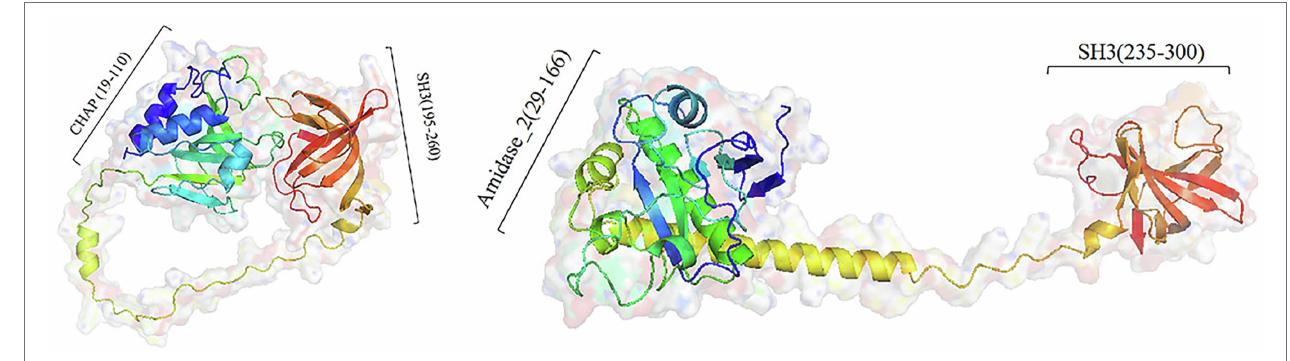
FIGURE 6 | Homologous model structure of lys210 (left) and lys211 (right). Full-length amino acid sequences of lys210 and lys211 were used for 3D homology modeling by Robetta server and visualized using PyMol software.